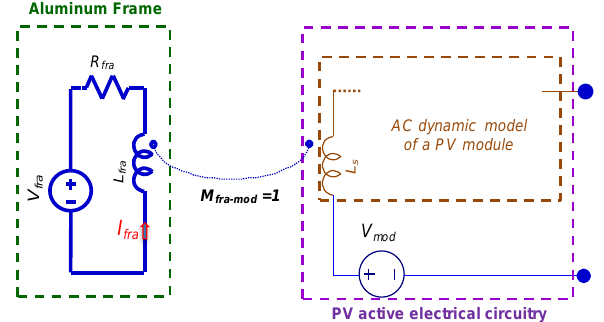
Figure 6. Lightning channel coupling model for the PV module.